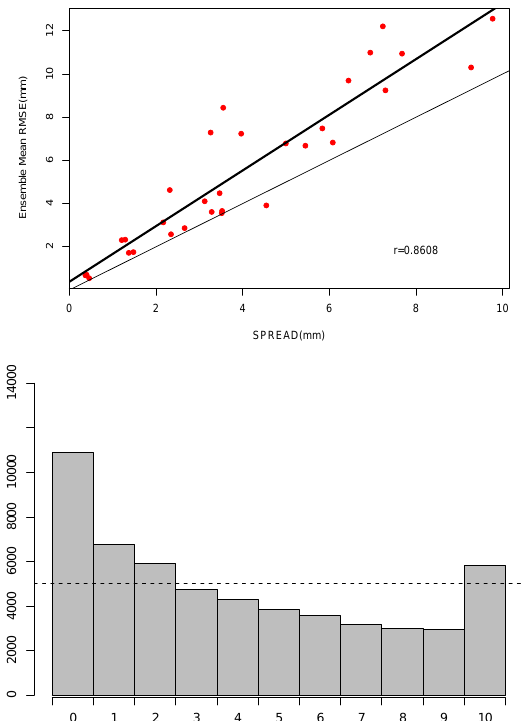
Fig. 4. (a) Scatter diagram of the ensemble RMSE (mm) and the ensemble spread (mm) for daily precipitation, showing in thin line the ideal diagonal; (b) Talagrand diagram showing the frequencies at which the verifying analysis falls in each category, defined by the 10 ordered ensemble members at each grid points. Dashed line represents the equiprobability line.